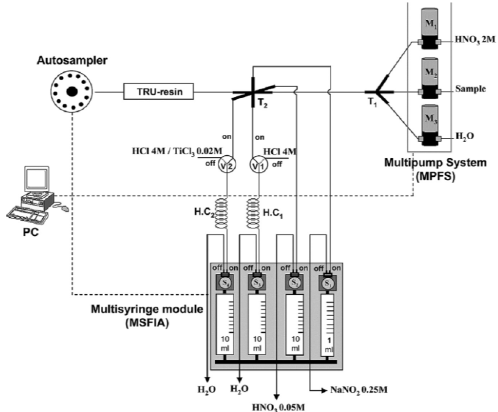
Figure 4. Schematic depiction of a multi-syringe flow injection analysis-multi-pump flow system (MSFIA– MPFS) [53].